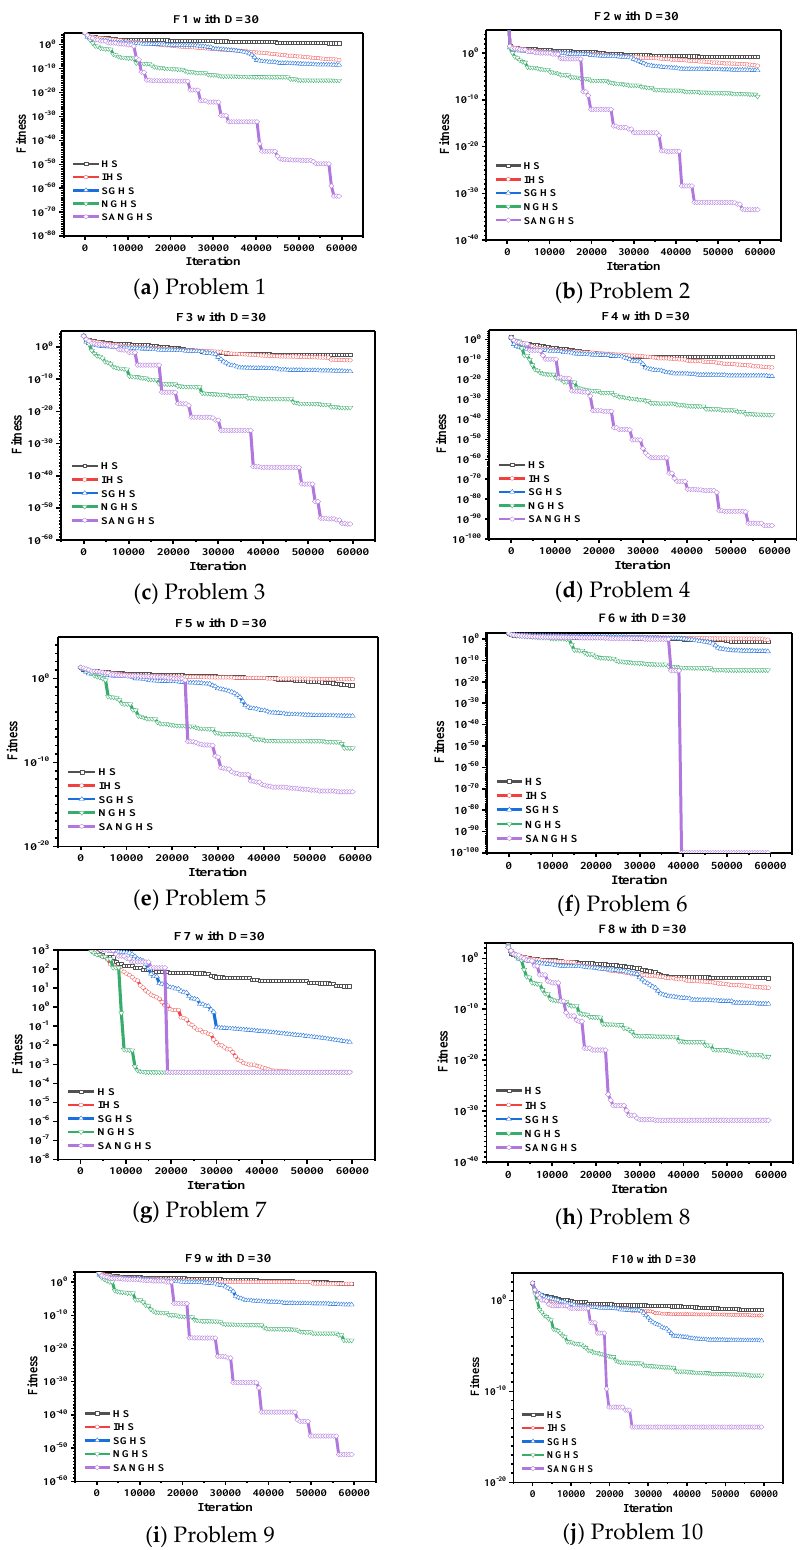
Figure 2. Typical convergence graph of five different algorithms for ten problems with D = 30. ( a ) problem 1; ( b ) problem 2; ( c ) problem 3; ( d ) problem 4; ( e ) problem 5; ( f ) problem 6; ( g ) problem 7; ( h ) problem 8; ( i ) problem 9; ( j ) problem 10.